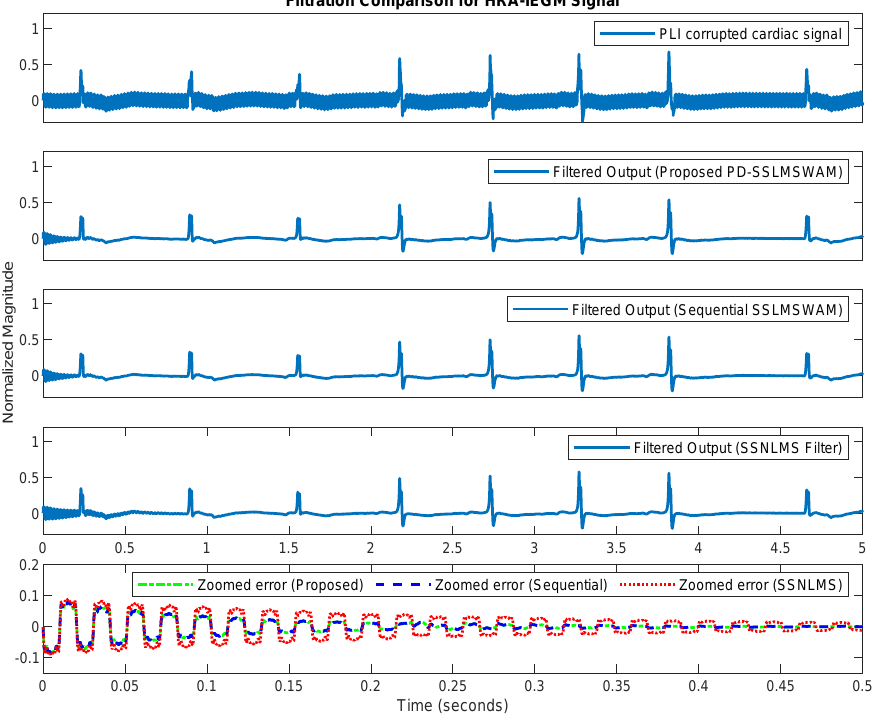
Figure 9. Filtration comparison among the proposed PD–SSLMSWAM, sequentially operated SSLM- SWAM, and SSLNLMS adaptive filters for the HRA–IEGM cardiac